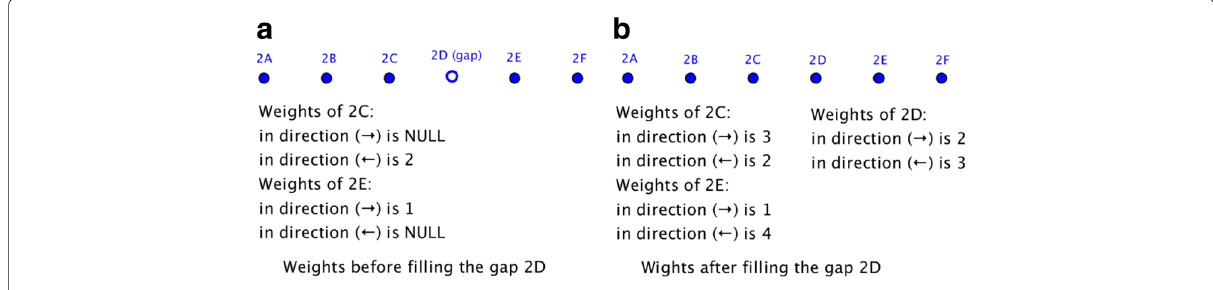
Fig. 4 Weight measurement in a 2-d SHAM. a Weights before filling the gap 2D. b Weights after filling the gap